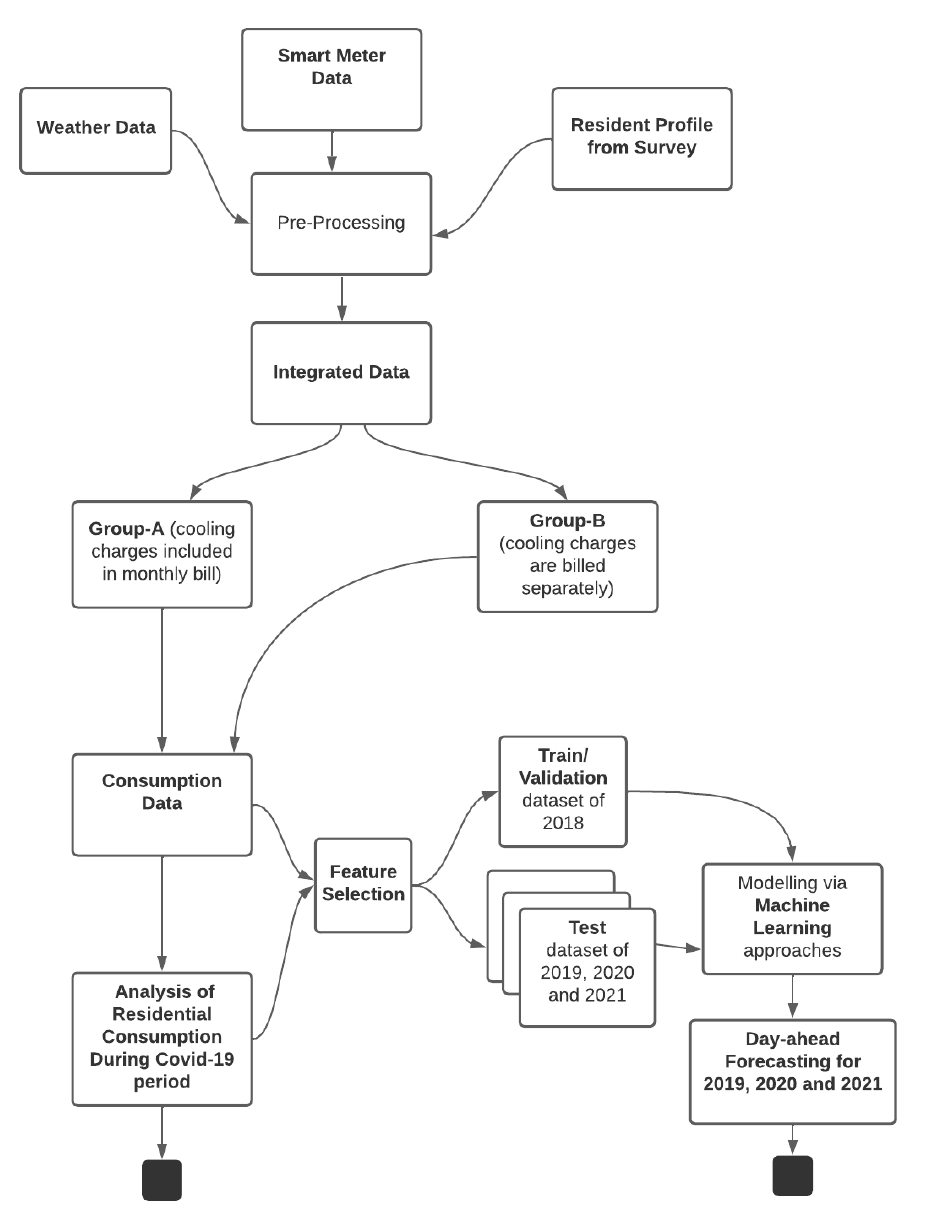
Figure 5. Flowchart of the approach